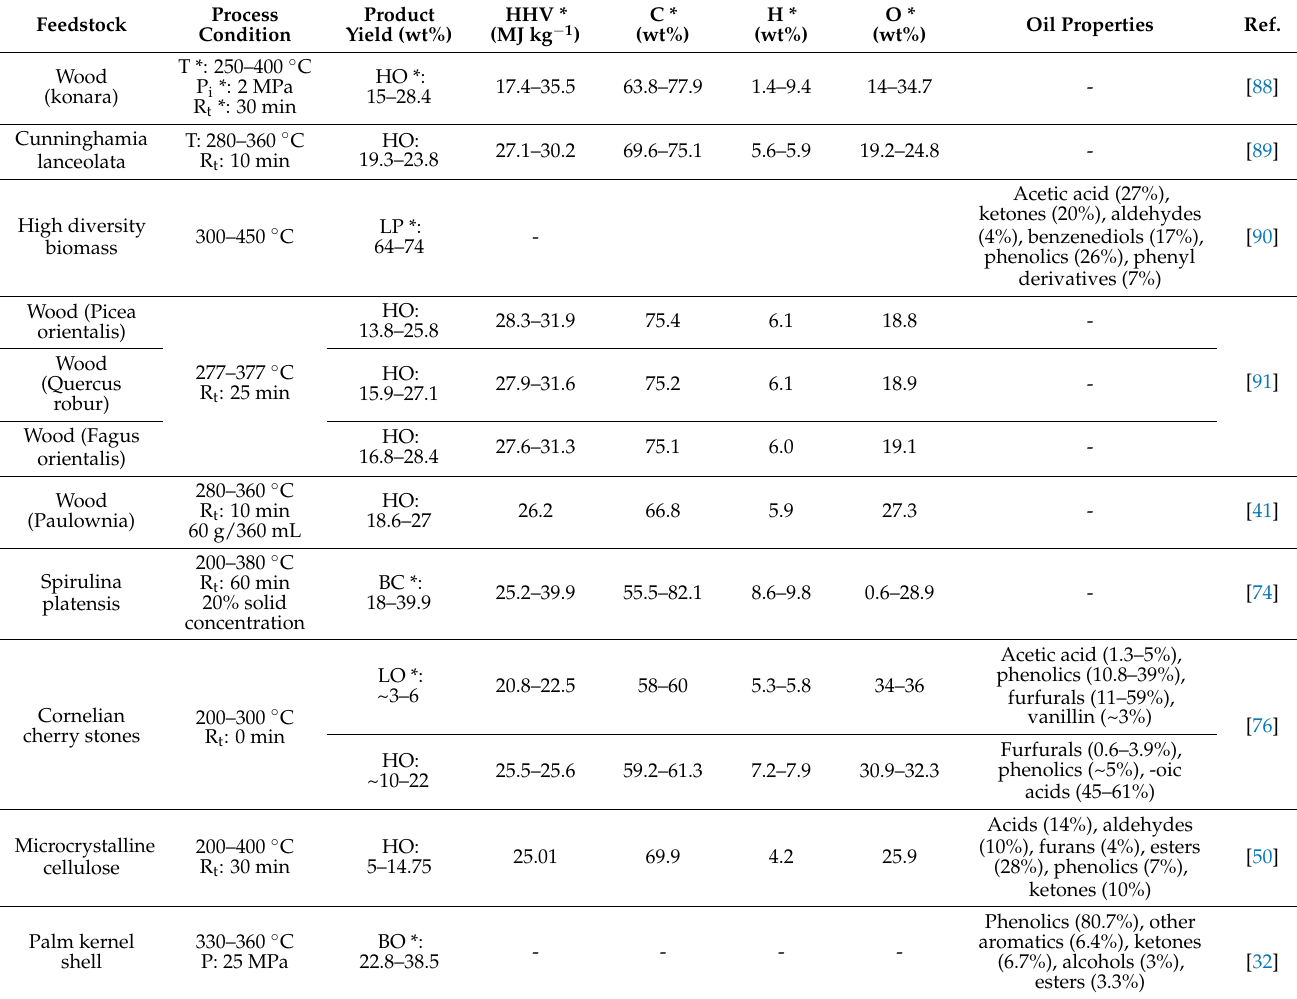
Table 3. Effect of temperature on HTL process and